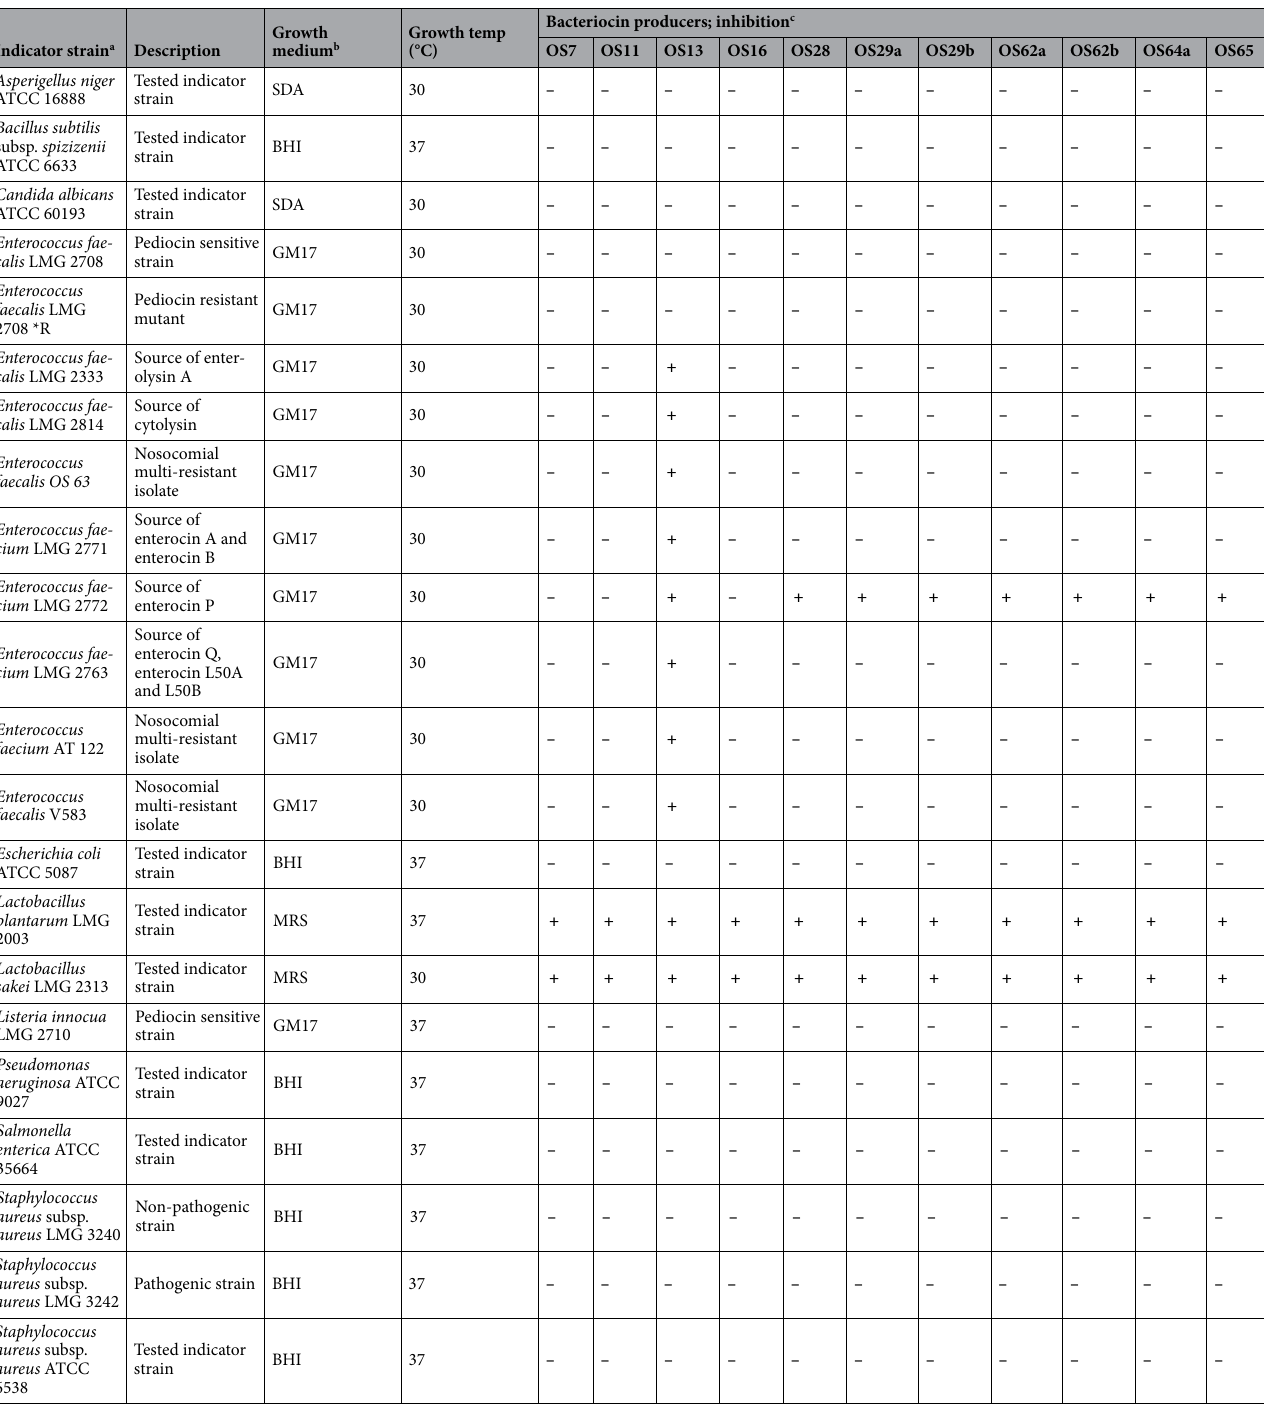
Table 1. Inhibition spectrum of BLIS from E. faecalis isolates using a deferred inhibition test method. a ATCC, “American Type Culture Collection”. b SDA, “Sabouraud Dextrose Agar”; BHI, “Brain Heart Infusion”; MRS, “deMan, Rogosa and Sharpe”; GM17, “Glucose-M17”. c + , clear inhibition zones of 12 mm or more were recorded as a positive antibacterial activity. – , no